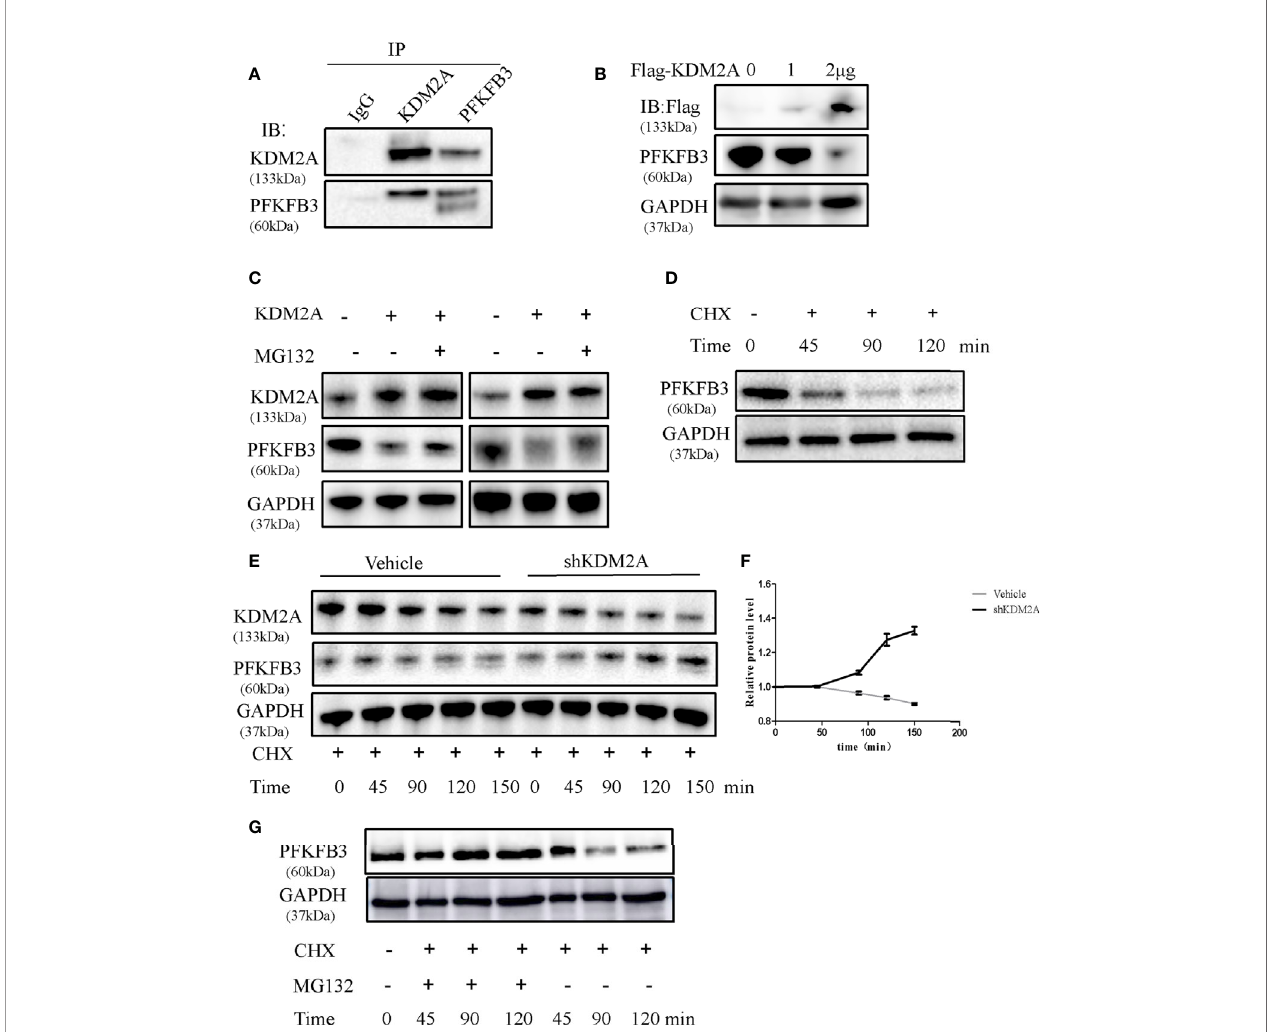
FIGURE 4 | KDM2A induces instability of PFKFB3. (A) Endogenous KDM2A and PFKFB3 interacted with each other in 293T cells, which was determined by Co-IP assay and Western blot. (B) Dose-dependent reduction of PFKFB3 in 293T cells transfected with KDM2A expression vector. GAPDH was used as loading control. (C) KDM2A induced ubiquitin proteasome system of PFKFB3. MM cells with KDM2A overexpression were treated with MG132 for 2 hours. PFKFB3 protein expression was evaluated as determined by Western blotting. (D) PFKFB3 protein degradation in MM cells treated with CHX in a time series. (E) Comparison of PFKFB3 protein degradation between the wild-type KDM2A and shKDM2A in cells with a time-course CHX treatment. (F) Quanti fi cation of (E) in triplicate. (G) MG132 inhibited the degradation of PFKFB3 protein detected by western blot